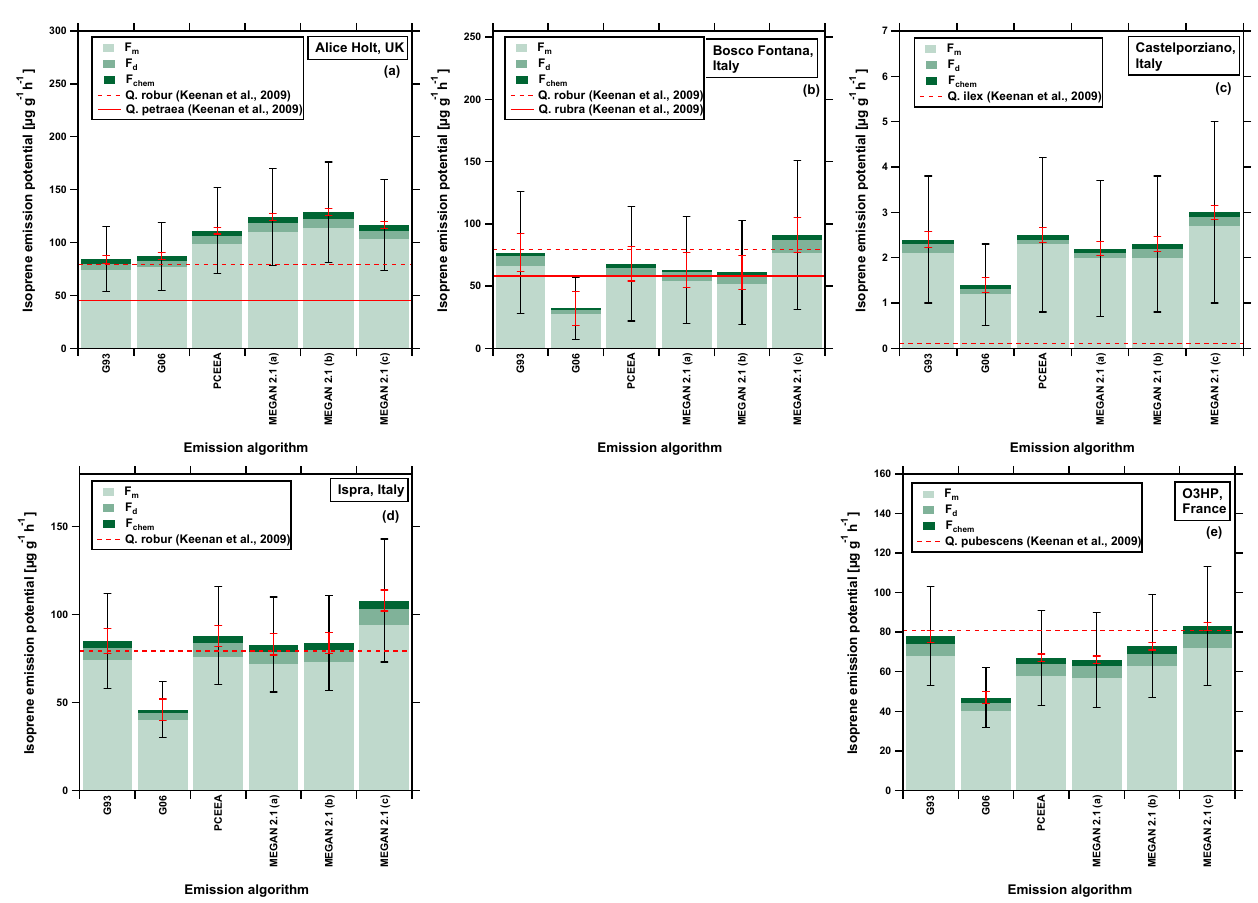
Figure 6. Graduated bars representing leaf-level equivalent isoprene emission potentials ( ε LL ) at each of the five measurement sites. Each bar shows (i) the calculated emission potential based upon measured fluxes ( F m ) , (ii) the correction applied for dry deposition ( F d ) and (iii) the correction applied for chemical flux divergence ( F chem ) . For each site emission potentials were calculated using six implementations of the Guenther algorithms (see Sect. 2.2 for details) and are shown relative to the leaf-level emission potentials reported by Keenan et al. (2009) (red line). The red error bars show the uncertainty in the emission potential that relates to the random error in the observed flux measurements. The black error bars show the total uncertainty (random and systematic errors). MEGAN 2.1 (a) is the full implementation of the model using calculated leaf temperature. MEGAN 2.1 (b) is the full implementation of the model using air temperature. MEGAN 2.1 (c) is a version of the model where only the effects of current environmental conditions (e.g. light and air temperature) are used. All algorithms have been optimised to equal unity at 1000µmolm − 2 s − 1 of PAR and